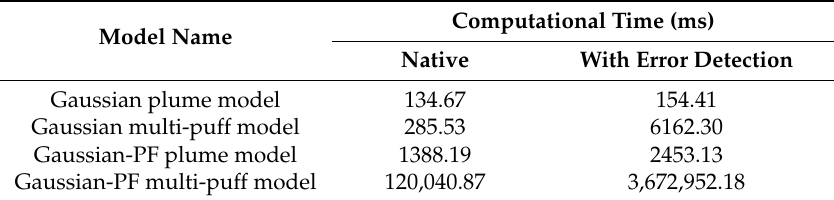
Table 4. Average computational time of each